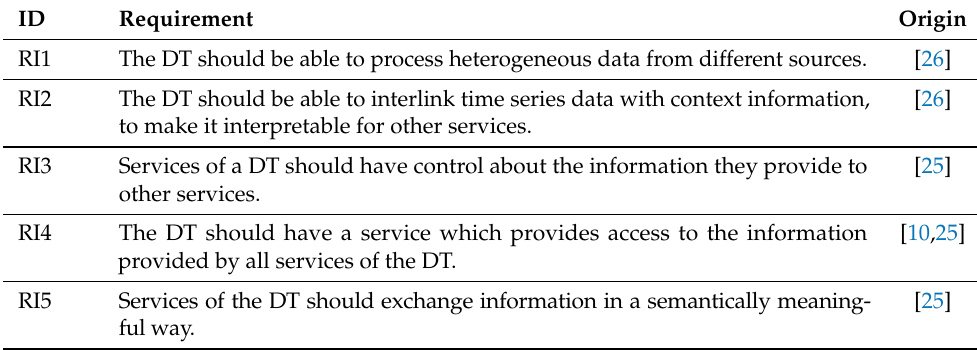
Table 2. Functional requirements for the Information